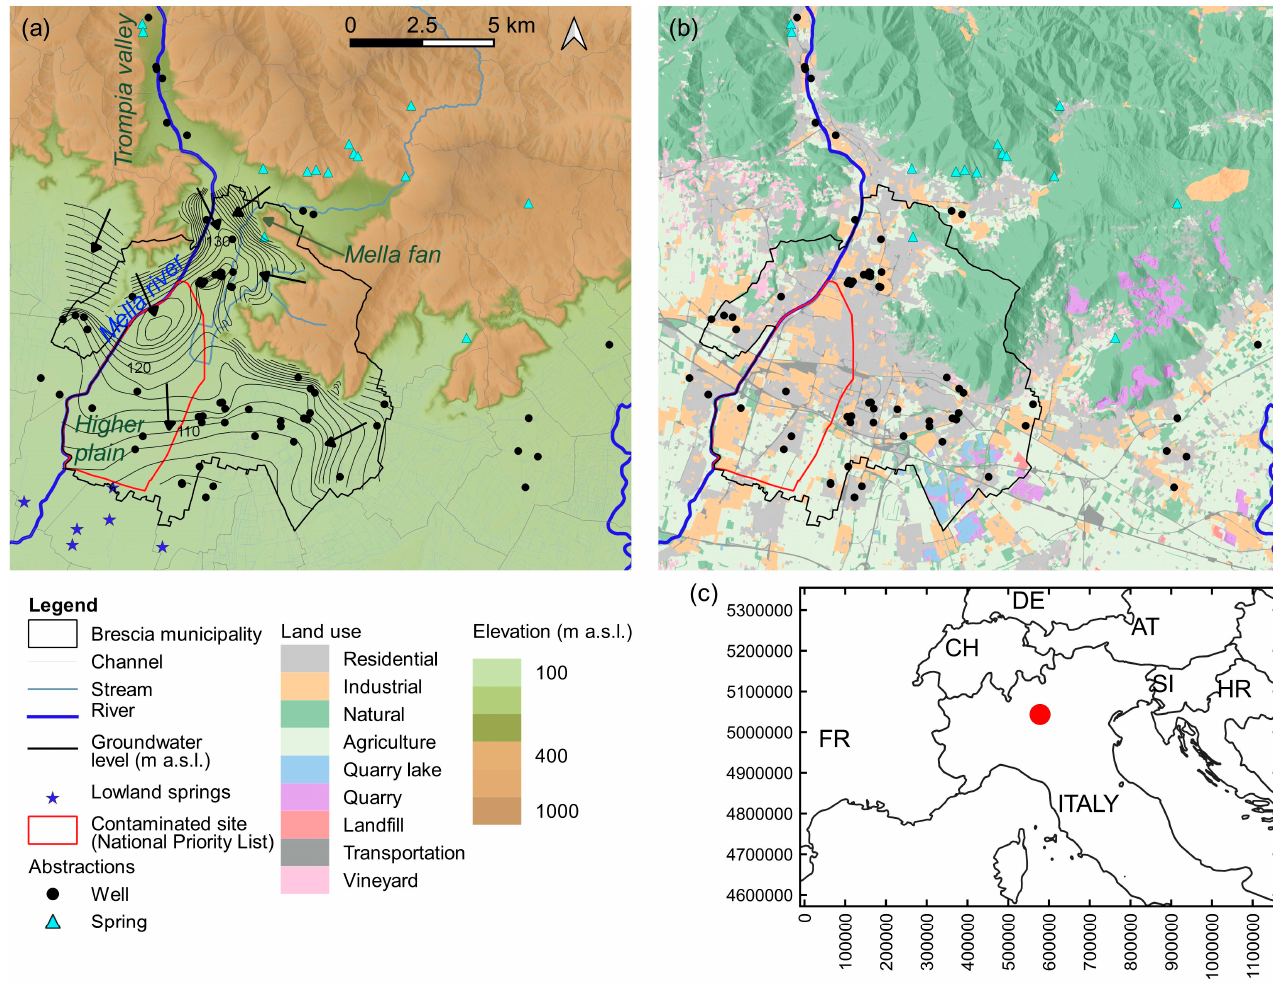
Figure 1. Study area: ( a ) elevation, and piezometric map by Osservatorio Acqua Bene Comune [40] and ( b ) land use, ( c ) study area location (WGS 84 UTM 32N). and ( b ) land use, ( c ) study area location (WGS 84 UTM